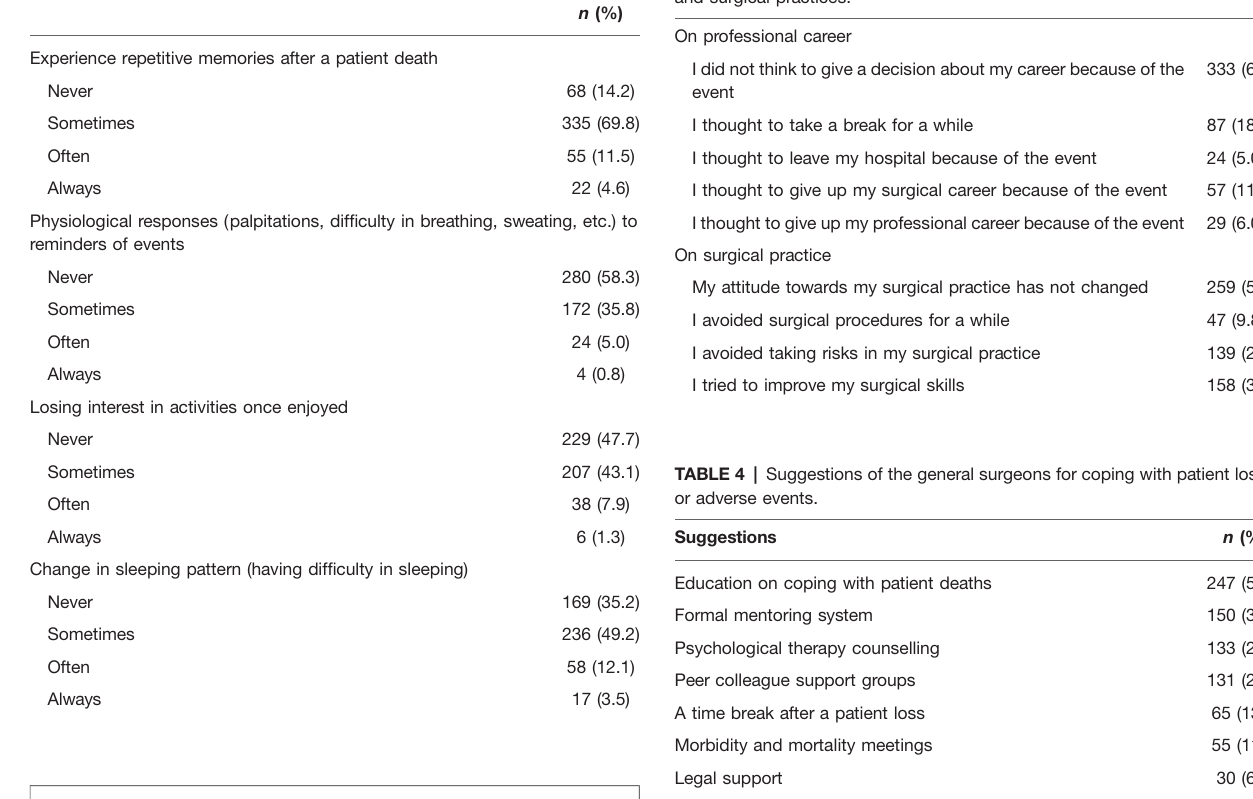
TABLE 3 | Impact of patient deaths on general surgeons ’ professional careers and surgical practices.